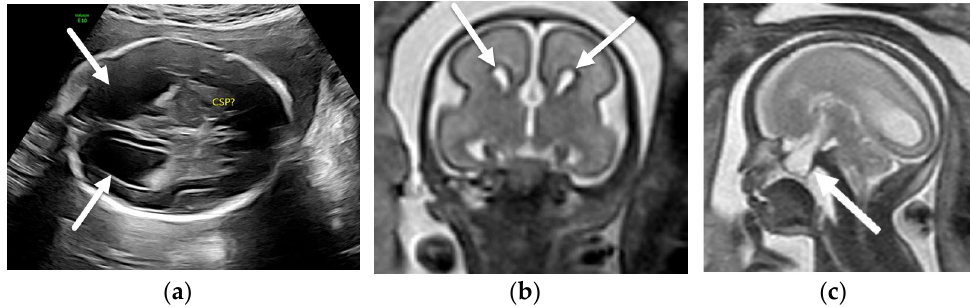
Figure 6. Agenesis of the corpus callosum in the Sakoda complex. Axial image of fetal ultrasound at 24 weeks GA ( a ) for cleft lip and palate (not shown) demonstrates absence of the CSP and colpocephaly (arrows) suspicious for agenesis of the corpus callosum. This is confirmed on subsequent fetal MRI at 24 weeks and 1 day GA. Coronal T2-SSFSE image of the brain ( b ) demonstrates upturned frontal horns of the lateral ventricles (arrows) and absence of the corpus callosum connecting the cerebral hemispheres. ( c ) Sagittal T2-SSFSE image in the same fetus reveals a large sphenoethmoidal encephalocele (arrow) projecting into the